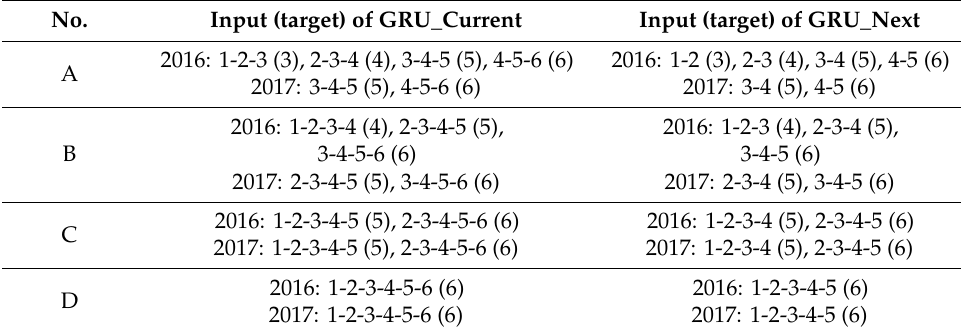
Table 4. Input imagery sequence and target dates of the two methods. The values in parenthesis indicate target dates.